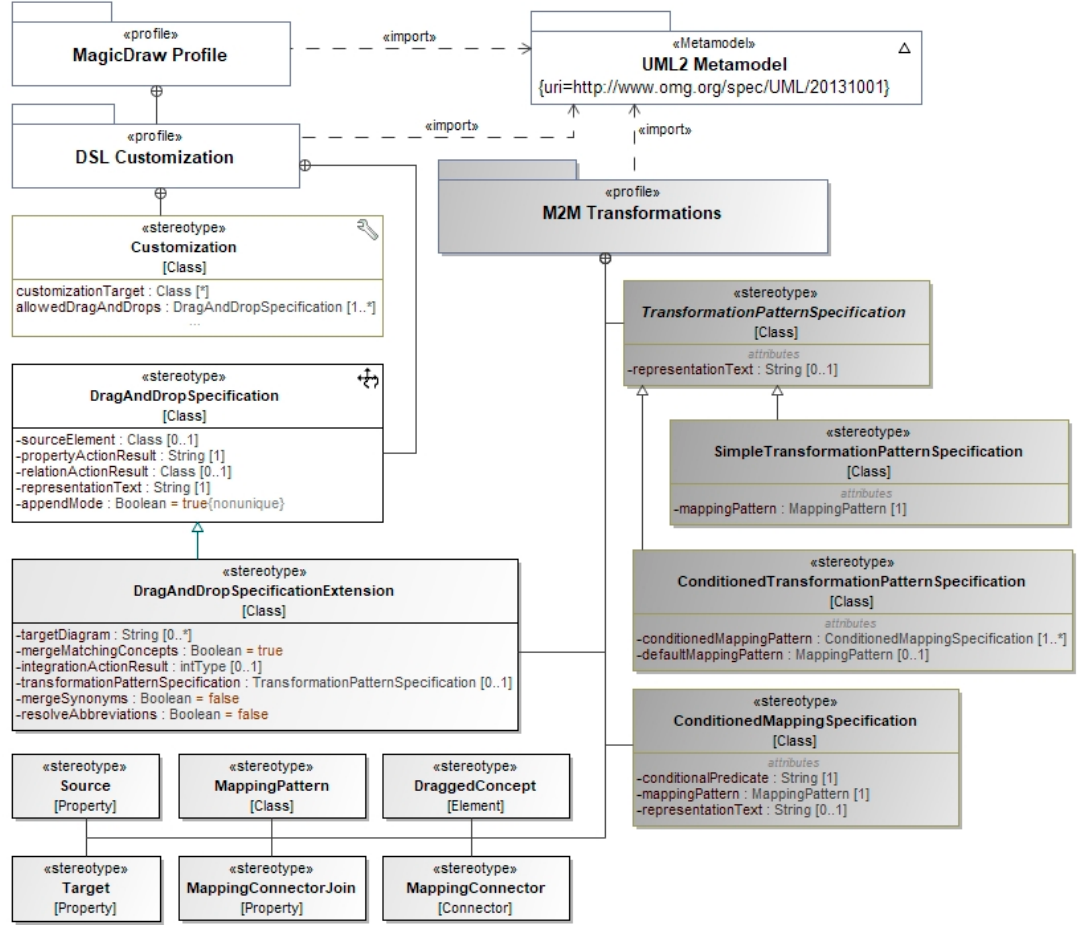
Figure 3. Overall architecture of unified modeling language (UML) profiles supporting the developed solution. Table 1. Specification of elements extending the original metamodel implementation.